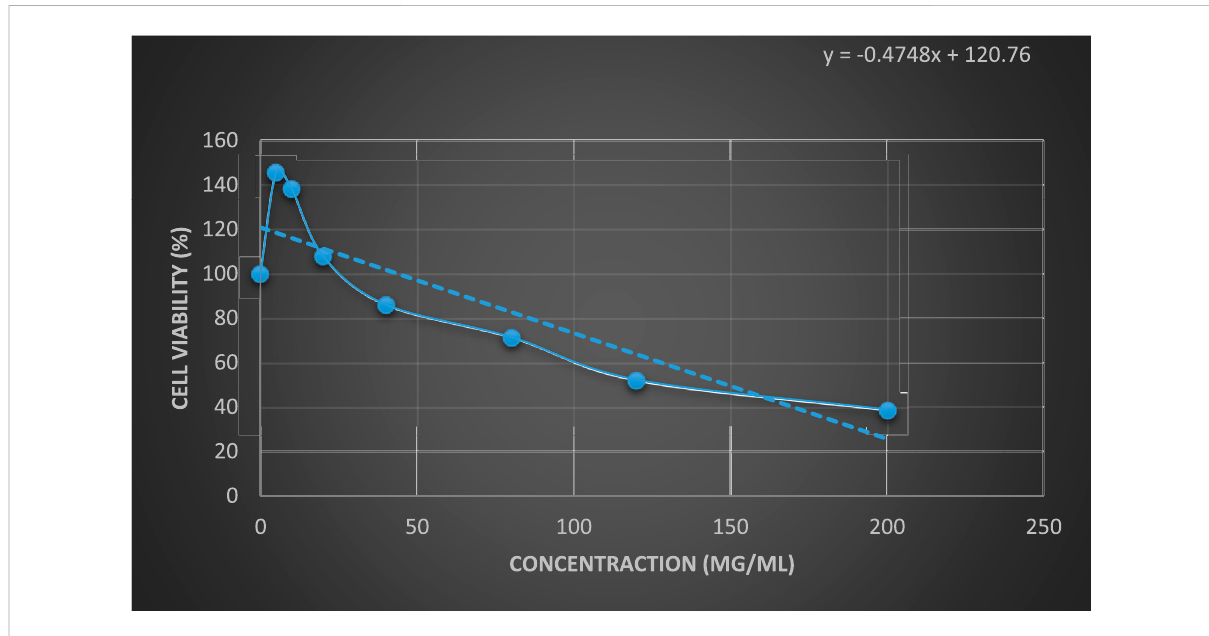
FIGURE 8 Anticancer activity of CCPSF NPs against MCF-7 breast cancer cells at 24 h. Data represented mean ( n = 3) ± SD.